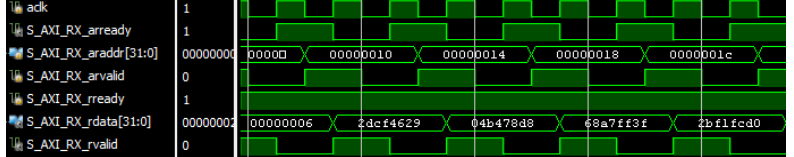
Fig. 6. The received OFDM payload (one data